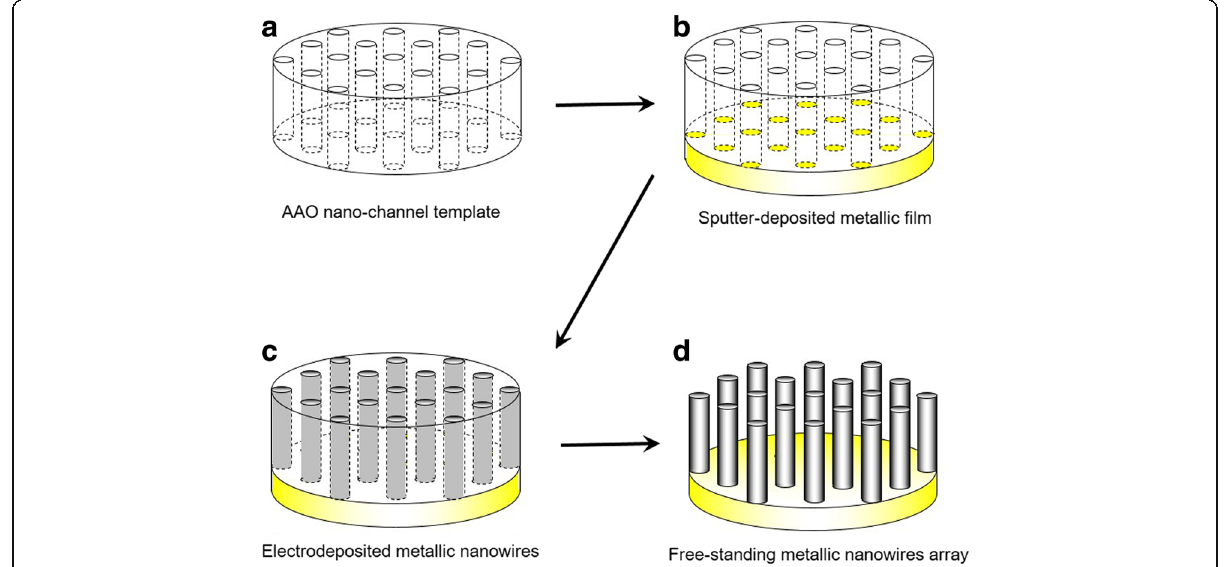
Fig. 1 Fabrication process of free-standing metallic nanowire array. a Anodized aluminum oxide nanochannel template, b sputter-deposited metallic film, c electrodeposited metallic nanowires, and d free-standing metallic nanowire